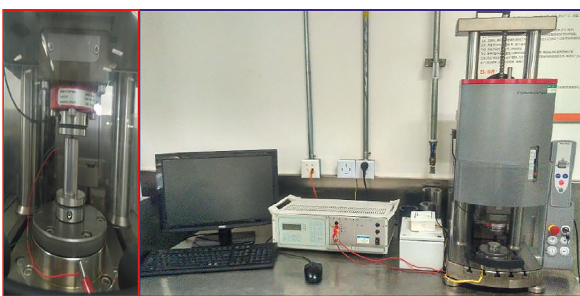
Figure 5: Testing platform of electromagnetic force.